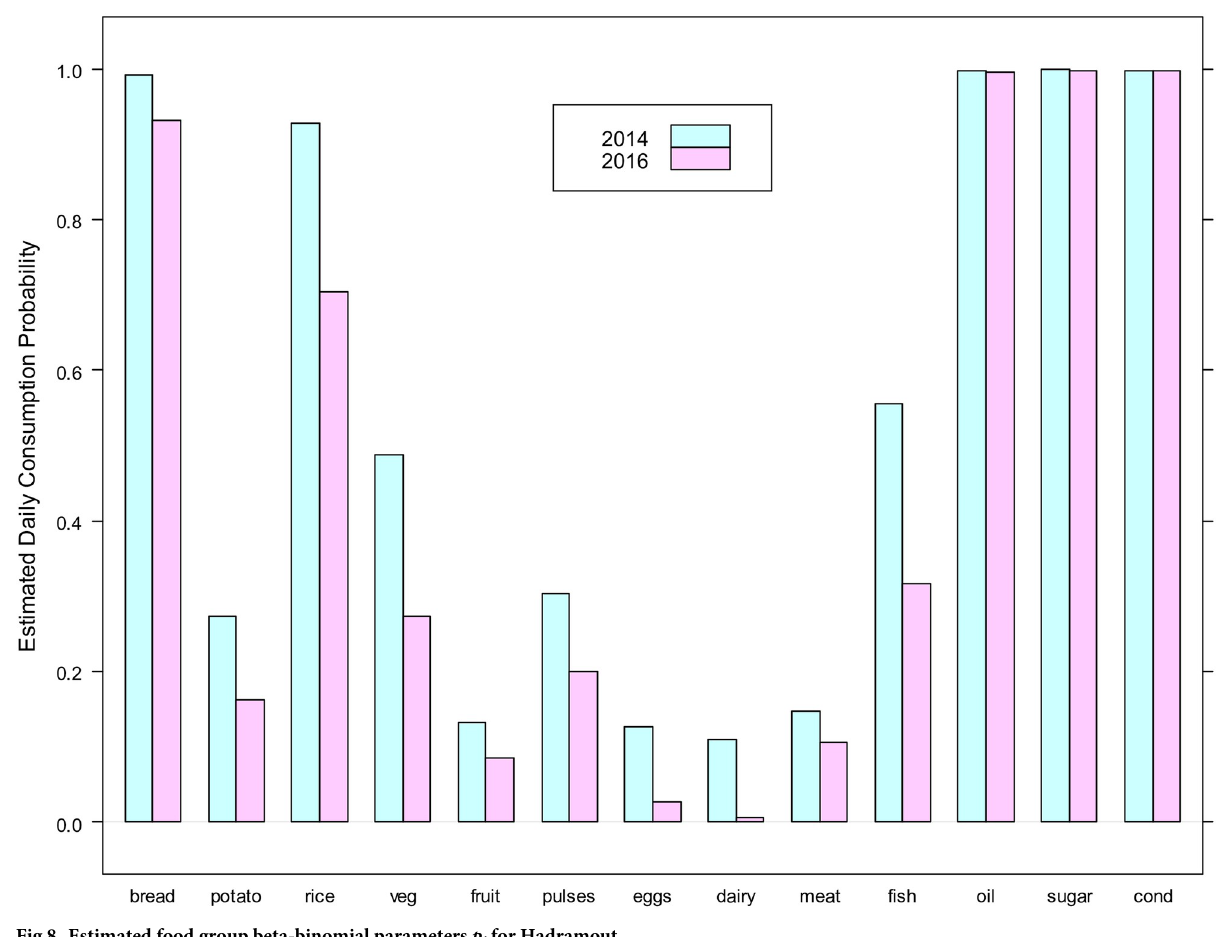
Fig 8. Estimated food group beta-binomial parameters p